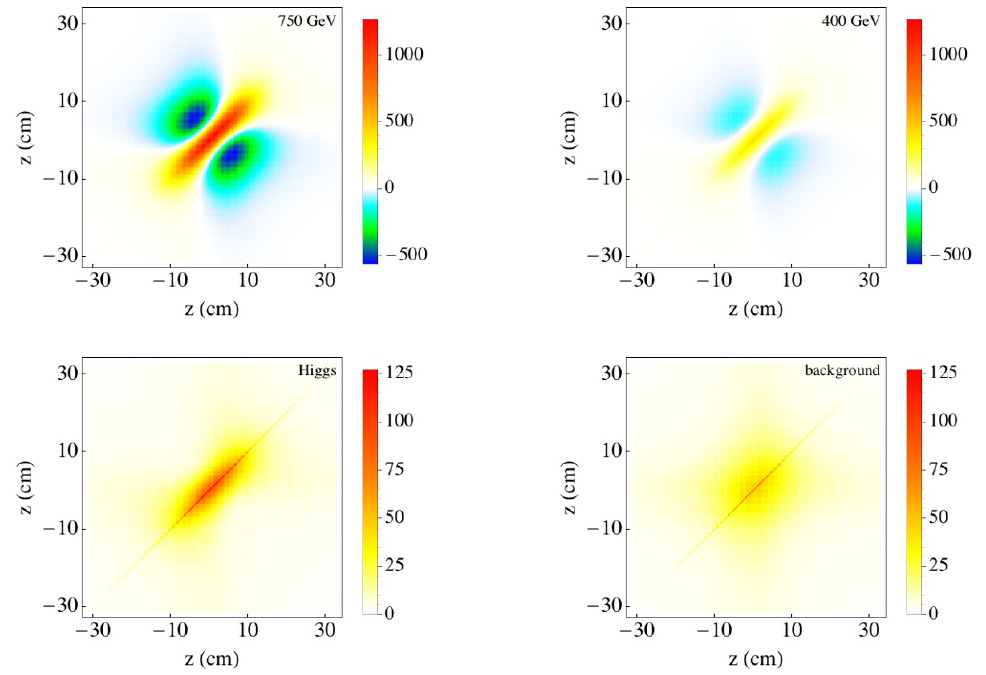
Figure 12. Graphical representation of the covariance matrices for the dijet background and the three signal benchmarks. The scale in the bottom row is 1/10 of that in the top row.